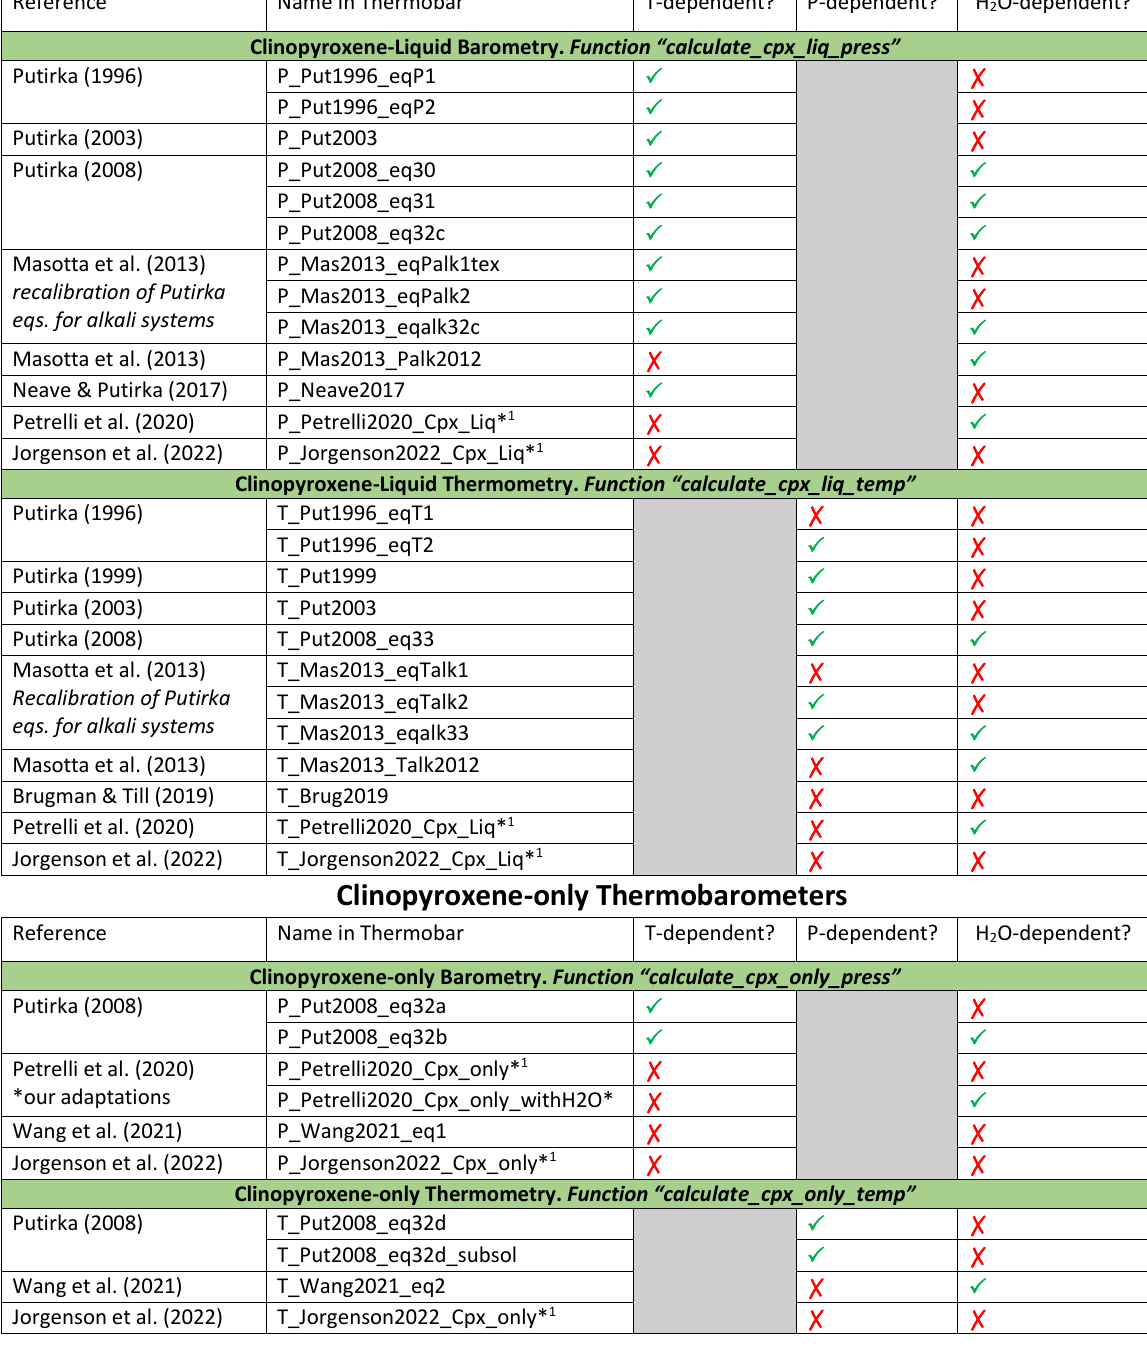
Table A4: Summary of equations for Cpx thermobarometry. Equations marked with *1 have two forms: in addition to that shown, users can also add _onnx (e.g. P_Petrelli2020_Cpx_only_onnx ). From: Putirka et al. 1996, Putirka et al. 2003, Putirka 2008, Masotta et al. 2013, Neave and Putirka 2017, Brugman and Till 2019, Petrelli 2021, Wang et al. 2021, Jorgenson et al.